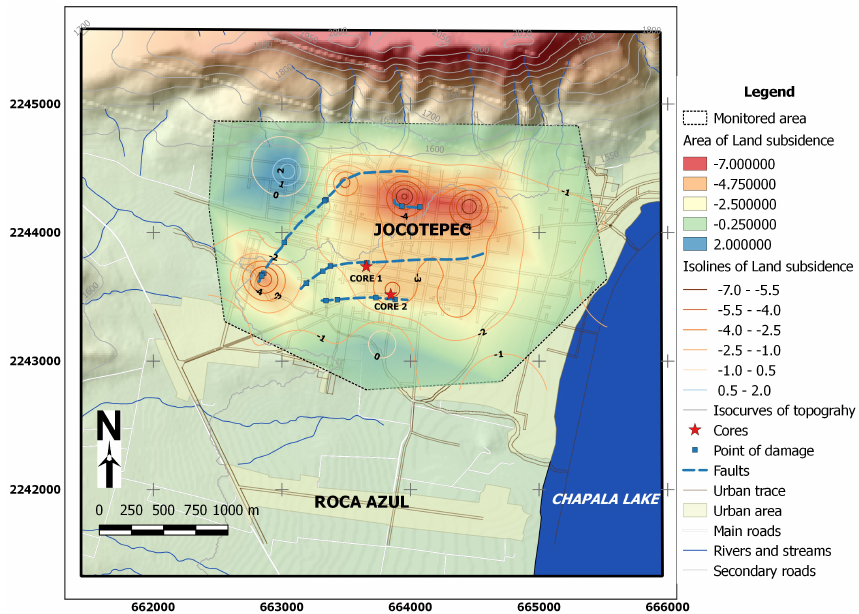
Figure 2. General characteristics of the study zone at west Chapala lake basin. Subsidence registered and fault alignments observed in 2012 are present. Also the two cores for geotechnical analysis of the subsoil are indicated. Units of area and isolines of land subsidence are in centimeters.